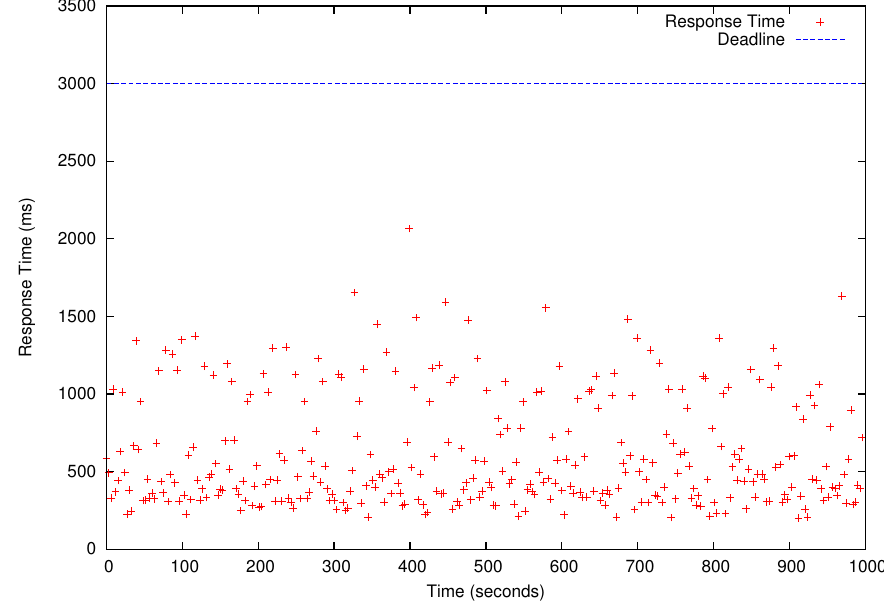
Figure 9. Response Times of Linear Regression (LR) Jobs. The blue horizontal bar is the deadline (3 s). Each red dot represents the response time of one periodic LR